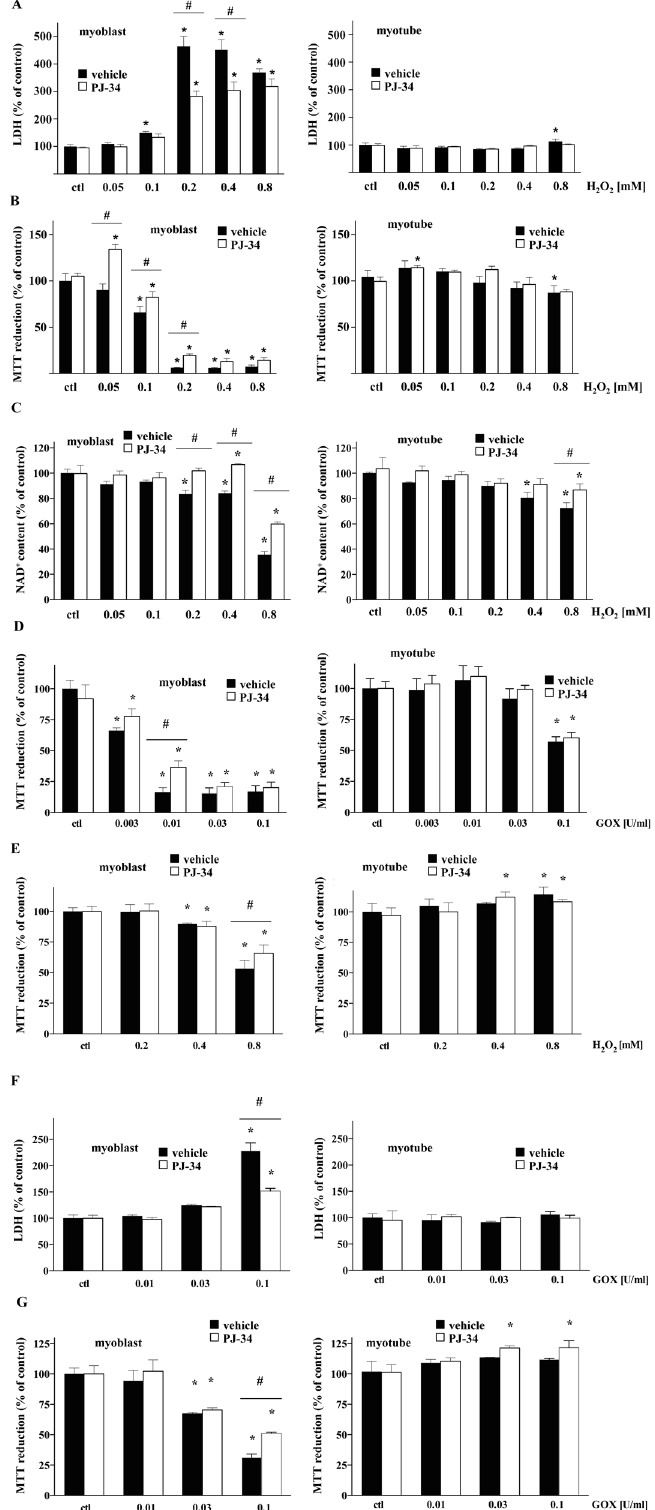
Fig 6. Myotubes are resistant to oxidant-induced loss of cell viability. Cell viability of myoblasts and myotubes in response to increasing concentration of oxidative stress was measured by LDH release (A, F)